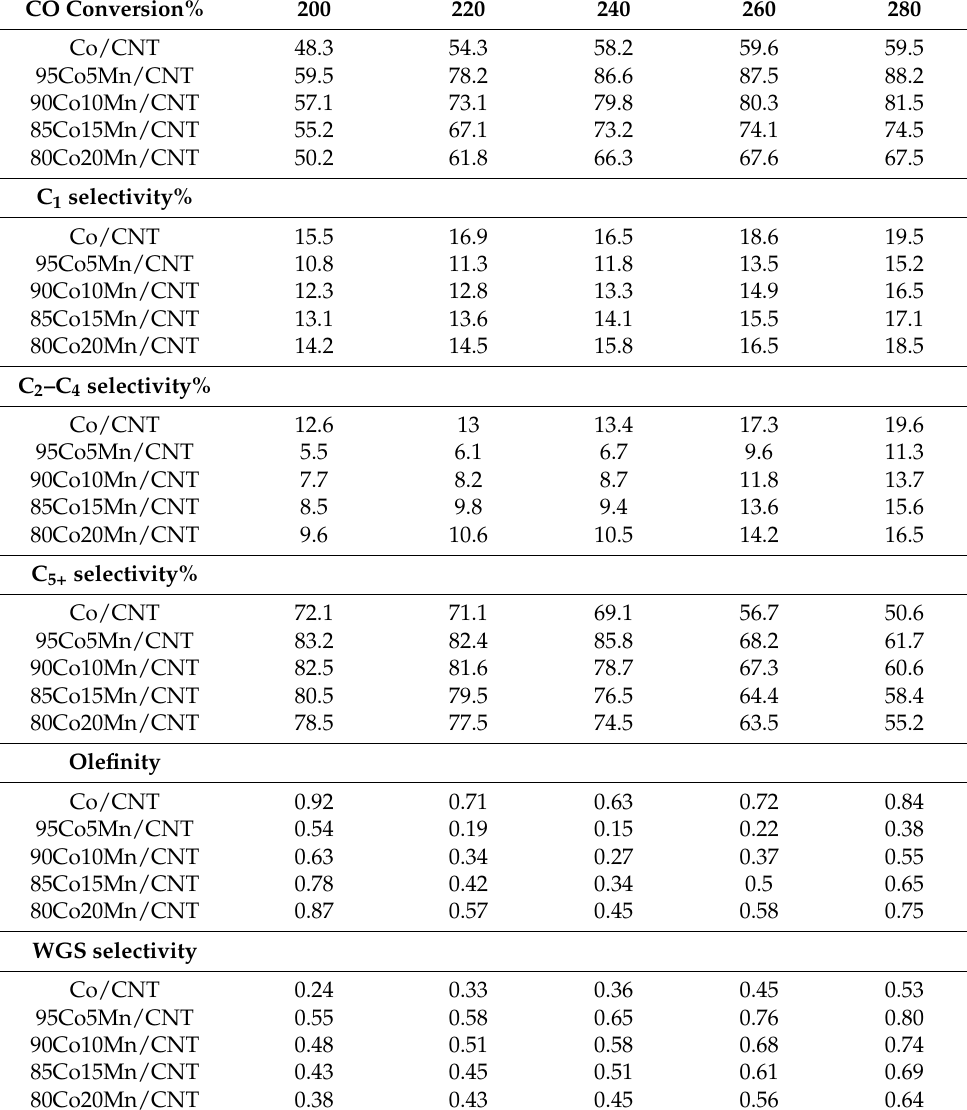
Table 1. Influence of reaction temperature ( ◦ C) on CO conversion%, C 1 selectivity%, C 2 –C 4 selectiv- ity%, C 5+ selectivity%, olefinity and WGS reaction *.